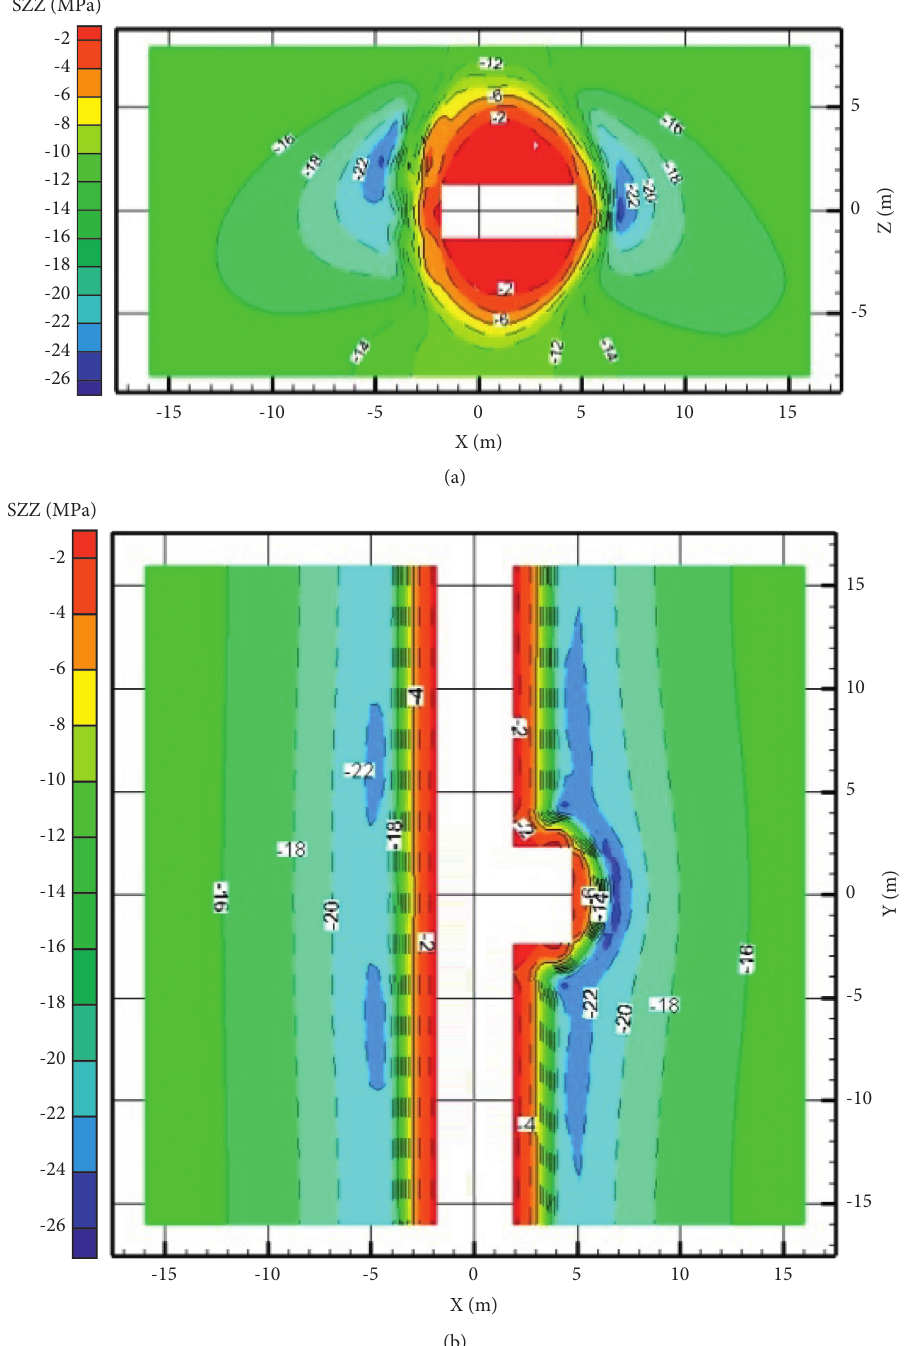
Figure 10: Vertical stress cloud contour in the surrounding rock. (a) Vertical cross section via the central of drilling field. (b) Horizontal cross section via the central of